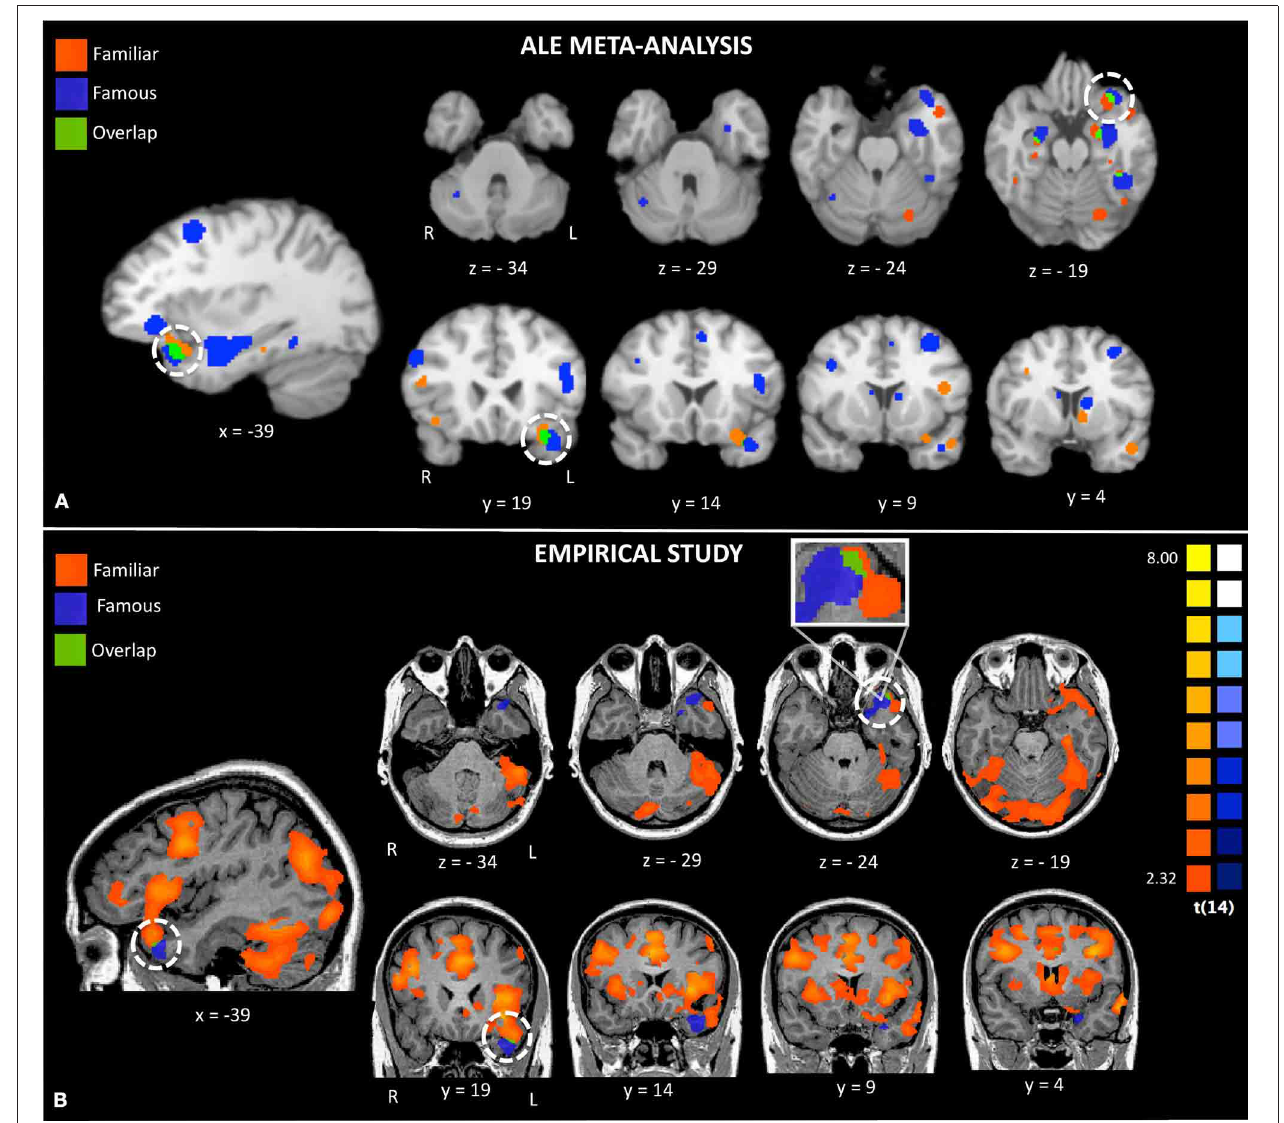
FIGURE 2 | Activations to famous and familiar faces from a random effects ALE meta-analysis (Panel A) and activations from random effects group analyses in the empirical study (Panel B). The white circles highlight activations to famous and familiar faces in the left anterior temporal lobe.